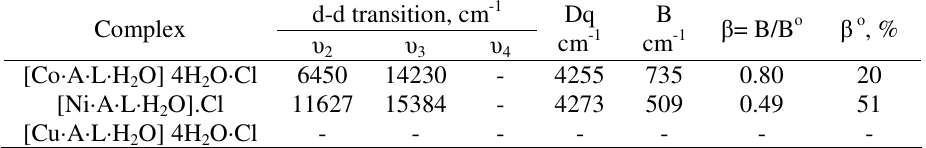
Magnetic moment Geometry µ (B.M.) eff